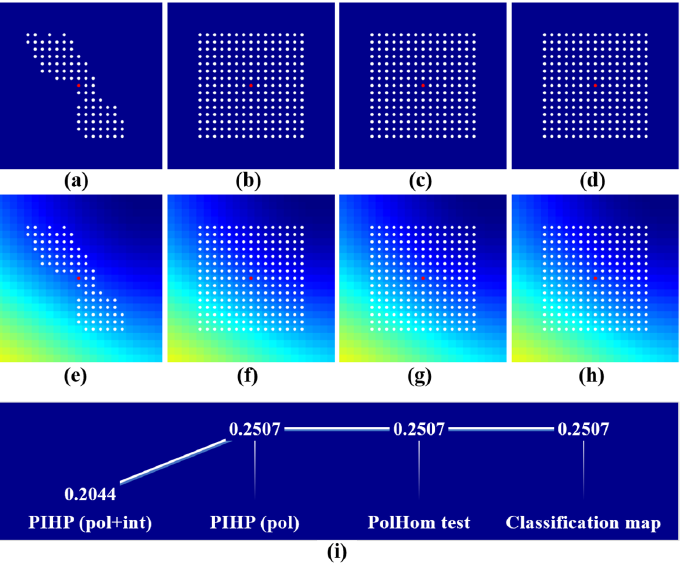
Figure 10. The homogeneous neighbors of pixel (58,99) with simulated interferogram base map by ( a ) PIHP method with P = 65, β = 9, ( b ) PIHP method with P = 65, β = 0, ( c ) PolHom test, ( d ) ground object type map. The homogeneous points of pixel (58,99) with deformation base map by ( e ) PIHP method with P = 65, β = 9, ( f ) PIHP method with P = 65, β = 0, ( g ) PolHom test, ( h ) ground object type map. ( i ) The corresponding σ ϕ of each